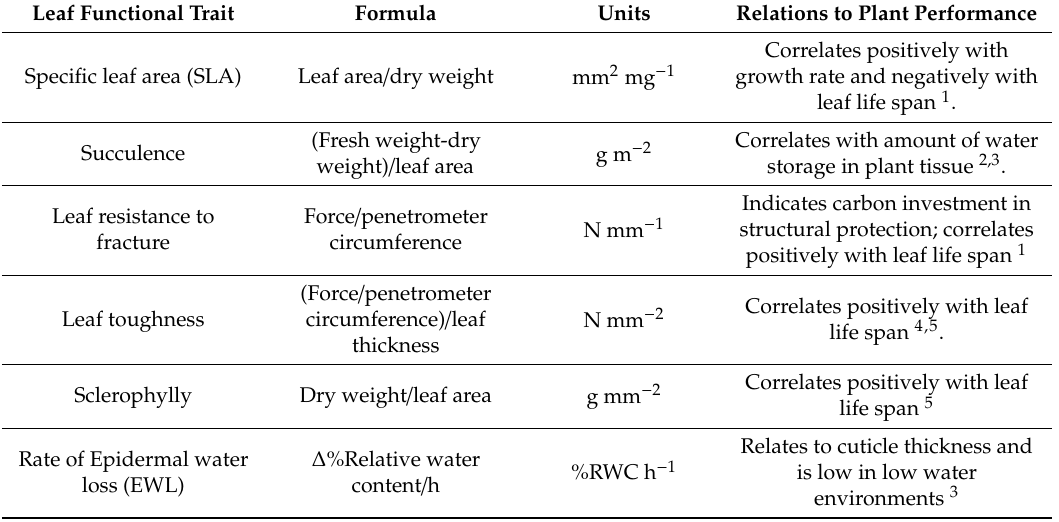
Table 2. Description of select leaf functional traits from epiphytic bromeliads found in Virola koschnyi trees at La Selva Biological Station in Costa Rica. Adapted from Woods 2013